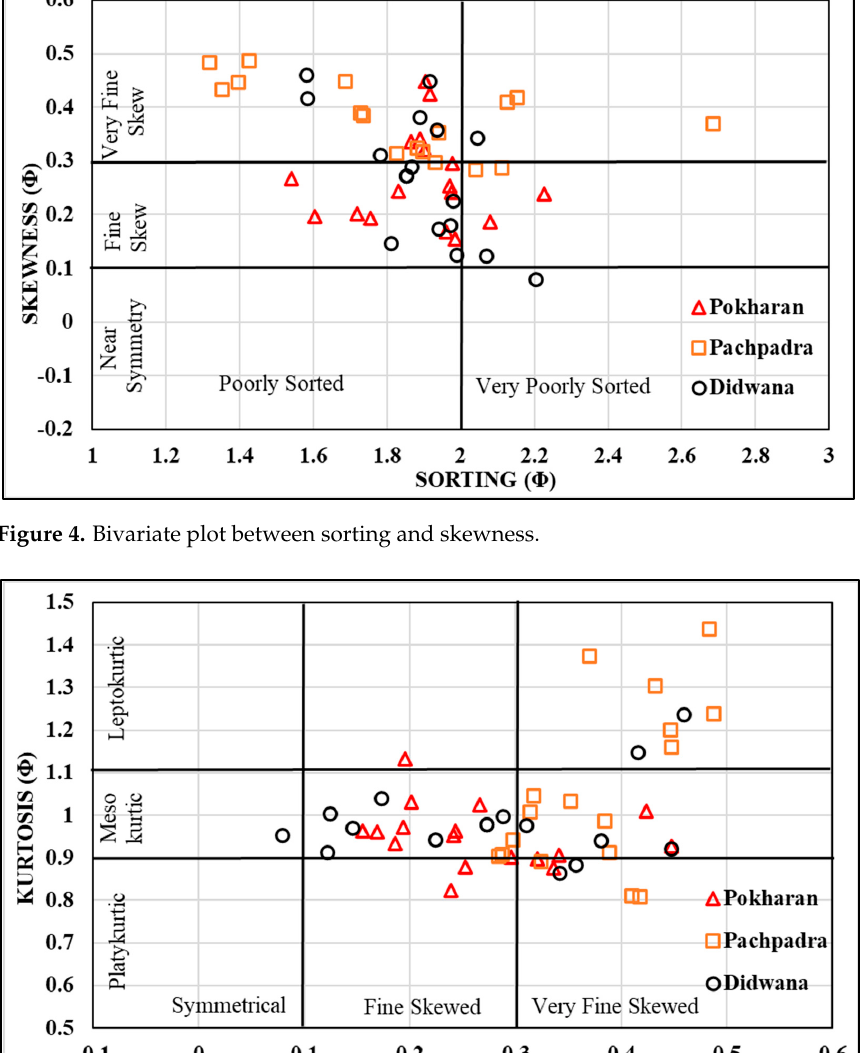
Figure 4. Bivariate plot between sorting and skewness.